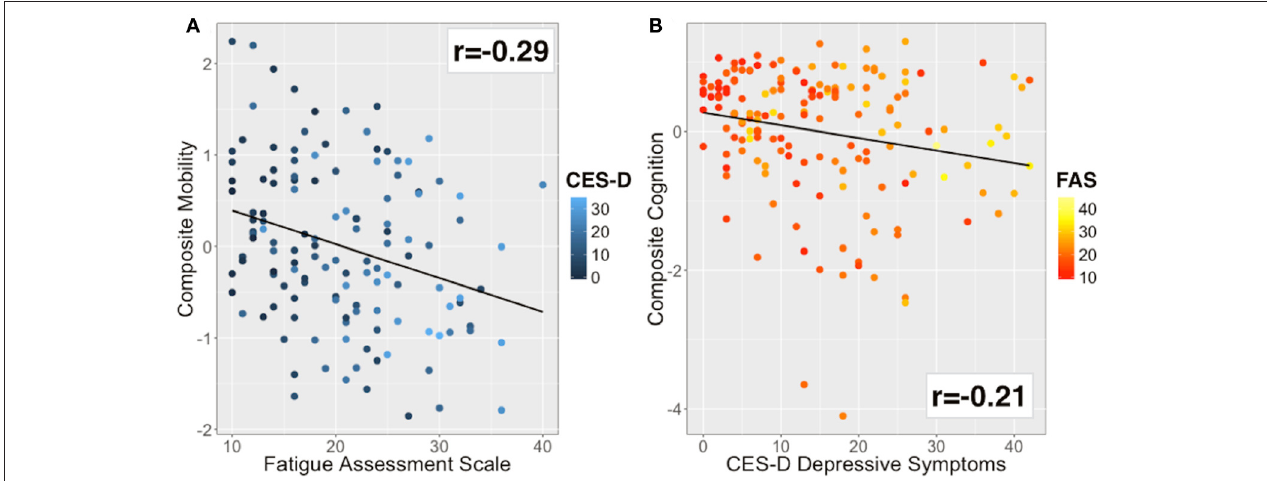
FIGURE 3 | Bivariate correlations for the main outcome and explanatory variables. (A) Mobility was inversely correlated with fatigue ( r = − 0.29). Color of data points based on CES-D (blue to cyan scale). (B) Cognitive performance was inversely correlated with depressive symptoms ( r = − 0.21). Color of data points based on FAS (red to yellow scale).